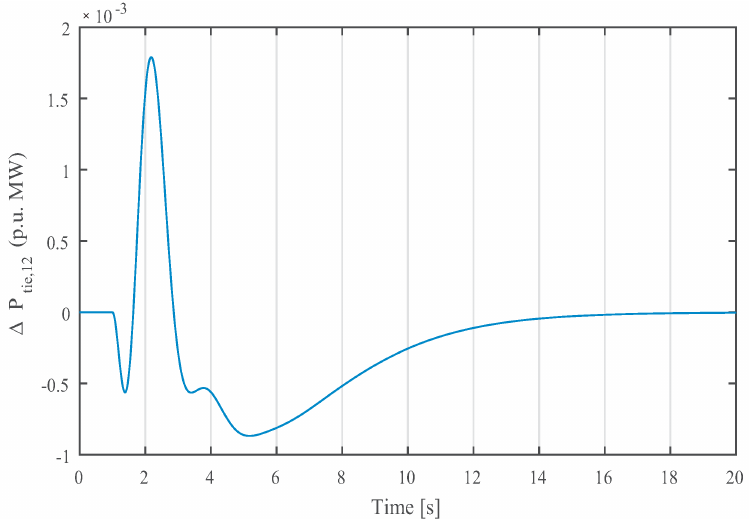
Figure 4. Power flow of V2G system not subjected to SOC.